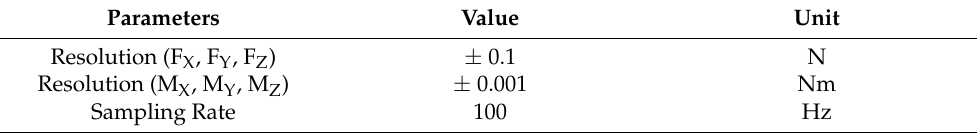
Table 7. Electrical specification of the six-axis F/M sensor.